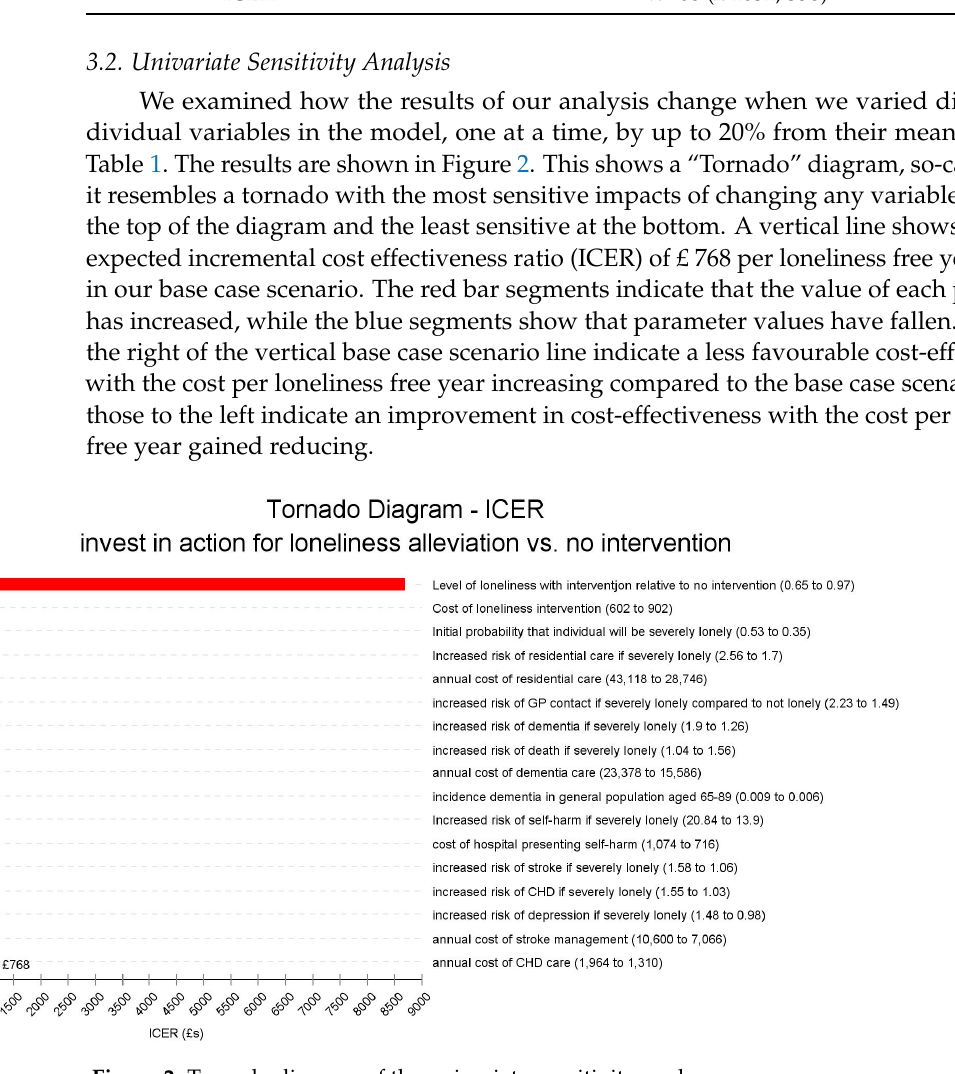
Figure 3. Tornado diagram of the univariate sensitivity analyses excluding the effectiveness parameter. 3.3. Probabilistic Sensitvity Analysis A probabilistic sensitivity analysis was also performed, using Monte Carlo simula- tion with 10,000 replications sampled from the distributions presented in Table 1. The cost-effectiveness plane for incremental cost-effectiveness of the loneliness alleviation in- tervention compared to no action from a health and social care perspective is shown in Figure 4. The elliptical circle includes 95% of the simulations in the model. In just 3.5% of the simulated pairs of costs and outcomes is the intervention dominant over no action, that is with lower costs and better outcomes. In the remaining simulations it is more ef- fective but more costly.